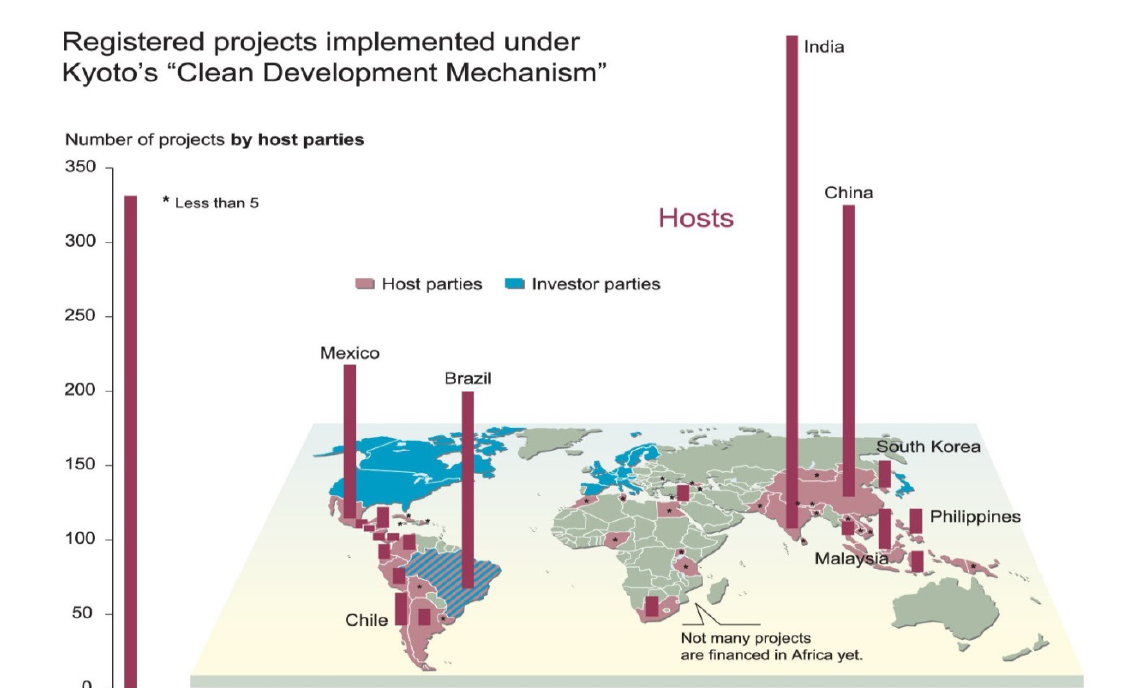
Figure 5. The Clean Development Mechanism: BRICS-Dominated Southern Carbon Trade